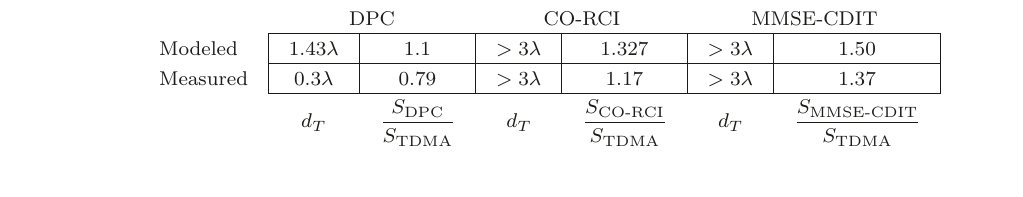
Table 1: Performance metrics for three transmit precoders with two channel realizations.